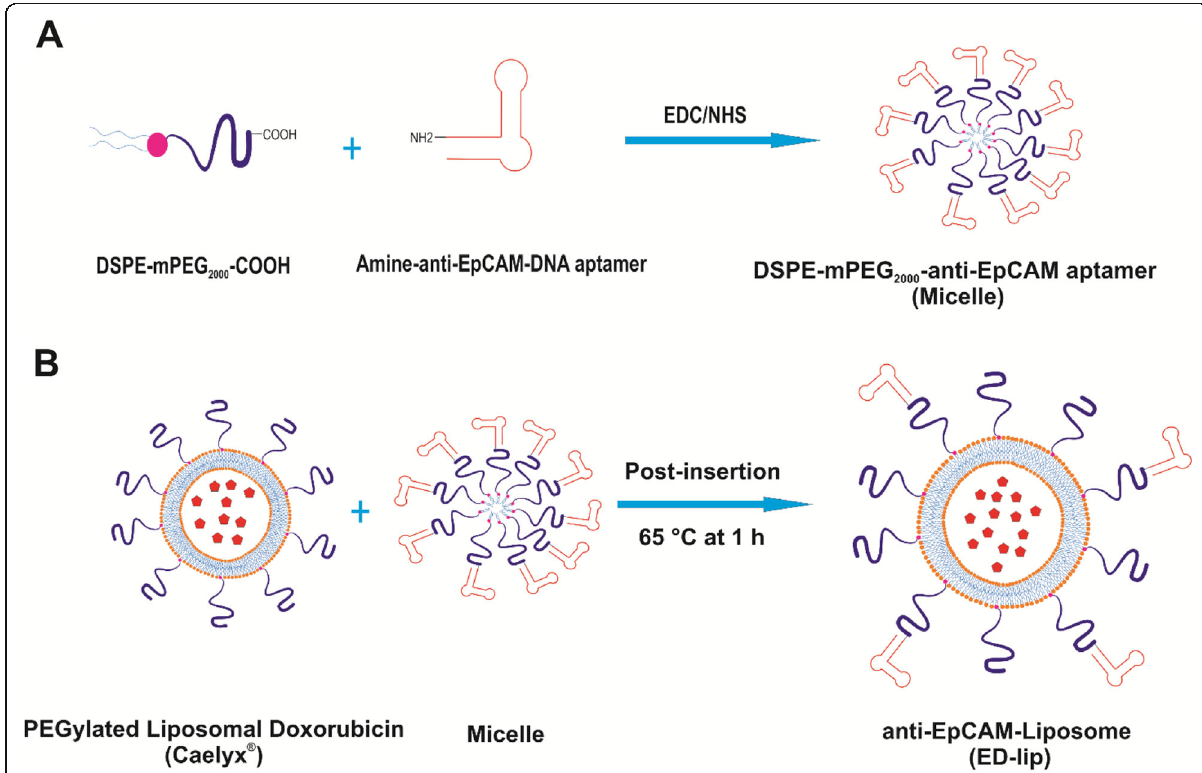
Fig. 1 Preparation of anti-EpCAM-functionalized Caelyx® (ED-lip). a Linking of anti-EpCAM aptamer to DSPE-mPEG 2000 through covalent binding of the primary amines (-NH2) of anti-EpCAM aptamer to the carboxyl group (-COOH) of DSPE-mPEG 2000 . b Post-insertion method for preparation of anti-EpCAM-functionalized Caelyx®